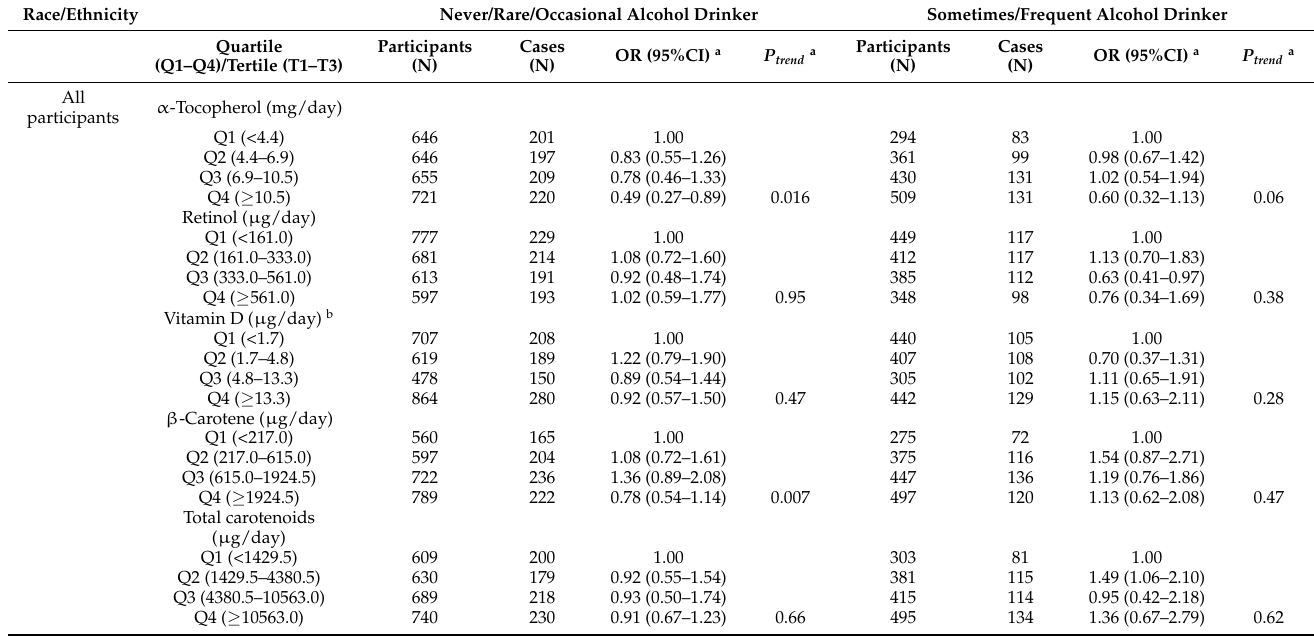
Table 4. Overall and Race/Ethnicity-Specific Associations of Dietary Micronutrients with Hepatic Steatosis by Alcohol Drinking